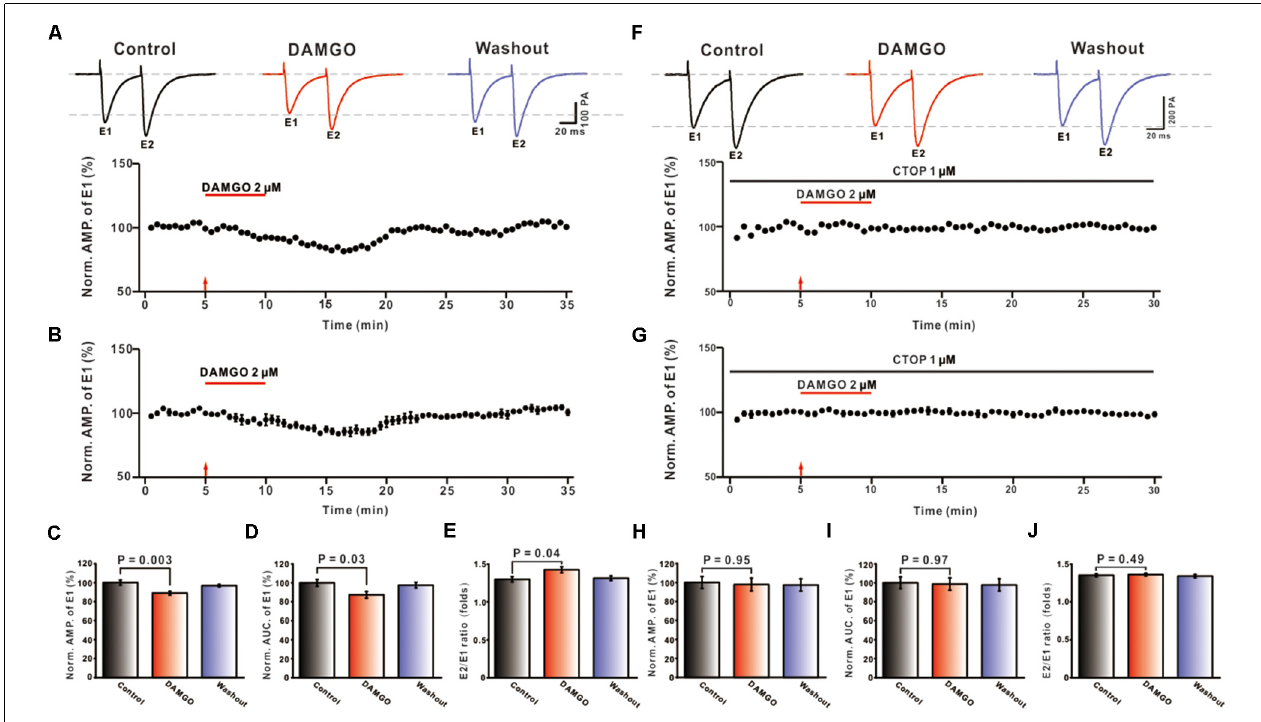
FIGURE 1 | Effects of MORs activation on PF-PC eEPSCs. (A) Representative traces of PF-PC eEPSCs induced by paired-pulse stimulation in control, DAMGO (2 µ M), and washout conditions (Top), and the time course of the DAMGO-induced changes in the amplitude of eEPSCs (Bottom). (B) Summarized results showing that DAMGO inhibited the evoked synaptic transmission of PF-PC in the cerebellar cortex ( n = 8). (C–E) Bar graphs showing the effects of DAMGO (2 µ M) on the normalized amplitude (C) , area under the curve (AUC, D ) of E2/E1 eEPSCs paired-pulse ratio (PPR, E ). (F) Representative traces of PF-PC eEPSCs induced by paired-pulse stimulation in control (1 µ M CTOP), DAMGO (2 µ M DAMGO + 1 µ M CTOP), and washout conditions (Top) and the time course of the DAMGO-induced changes in amplitude of eEPSCs in the presence of CTOP (1 µ M; Bottom). (G) Summarized results showing that CTOP blocked the inhibited synaptic transmission of PF-PC caused by DAMGO in the cerebellar cortex ( n = 8). (H–J) Bar graphs showing the effects of DAMGO (2 µ M) on the normalized eEPSC amplitude (H) , AUC (I) , and PPR (J) in the presence of CTOP (1 µ M).